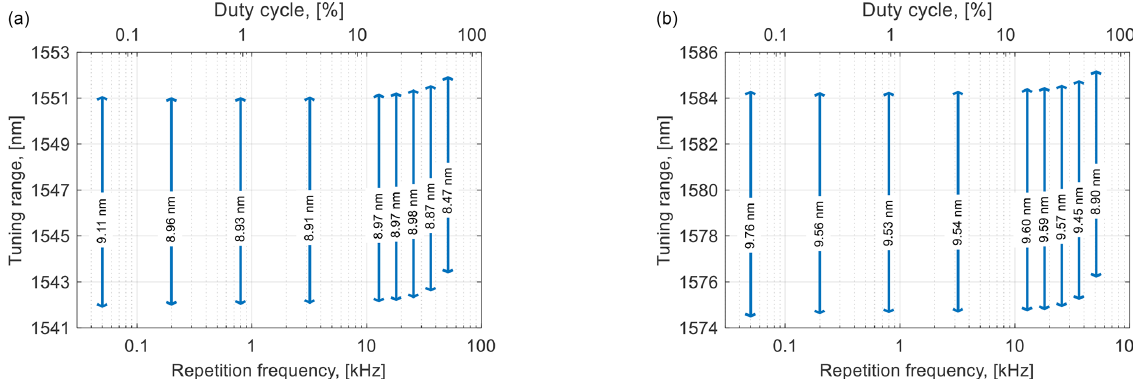
Figure 9. Tuning range within 12µs pulse for (a) VCSEL VL-1544 ( i B = 1, i P = 24mA) and (b) VL-1577 ( i B = 1, i P = 18mA) as a function of the pulse repetition